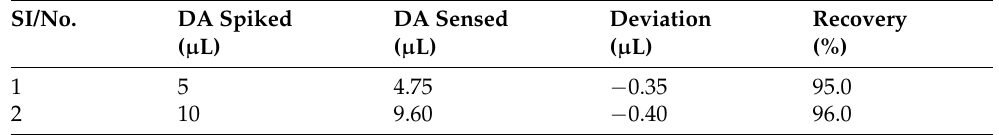
Figure 7. Graph of Ipa vs. concentrations. Table 2. Results of DA analysis in real